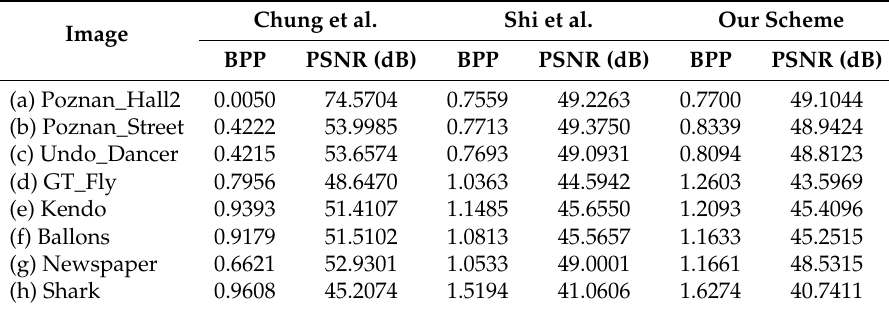
Table 2. PSNR comparison for maximum BPP on each image using various methods.